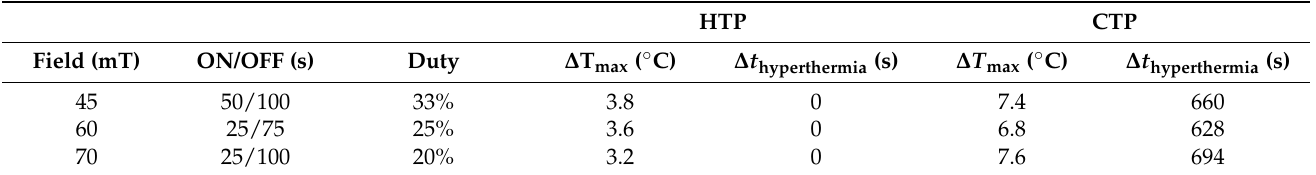
Table 1. Summary of PMF hyperthermia results with the optimum ON/OFF times and Duty Cycles found for each magnetic field value (45, 60 and 70 mT).